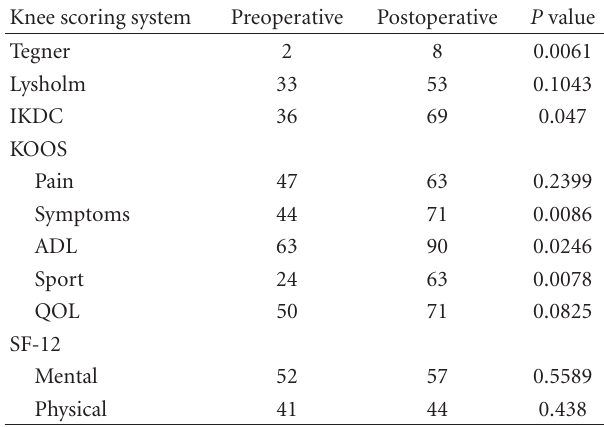
Table 2: Outcome score changes from preoperative results to final results, with P value for all outcome